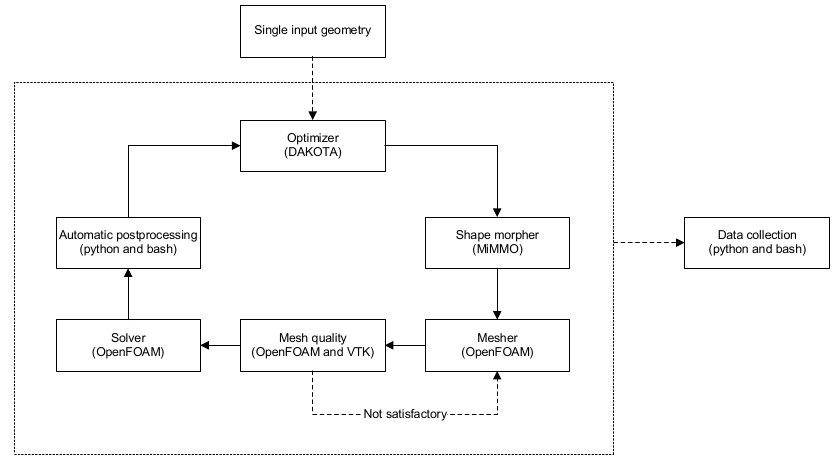
Figure 1. Optimization loop. Notice that it only takes one single geometry. During the whole optimization loop, data are continuously